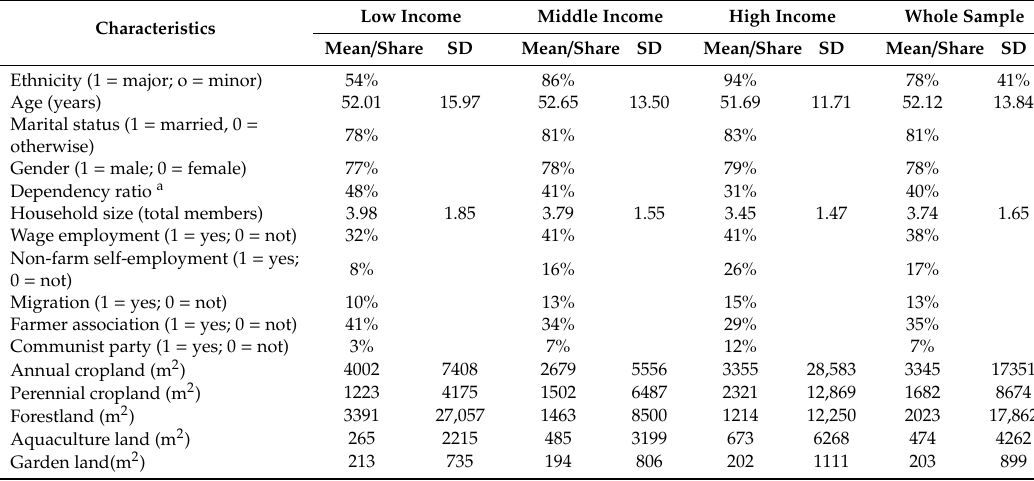
Table 2. Household characteristics by income